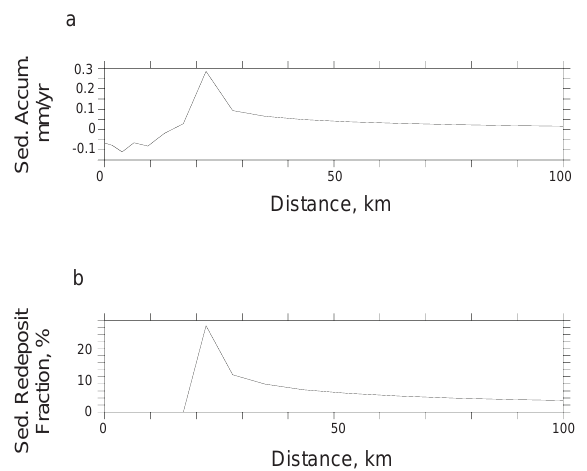
Fig. 4. (a) Total sediment accumulation rate and (b) redeposition fraction for the Base scenario.